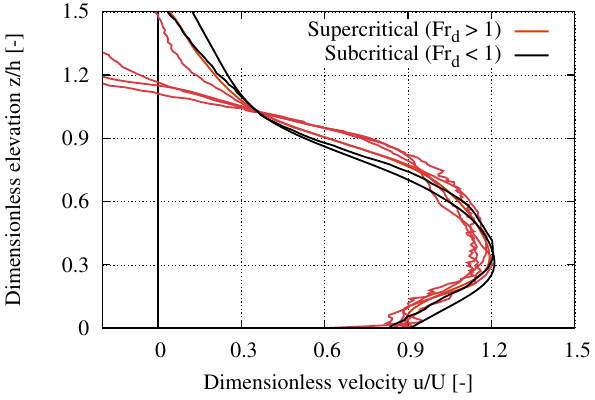
Figure 15. Comparison between subcritical ( Fr d < 1) and super- critical ( Fr d > 1) experiments.